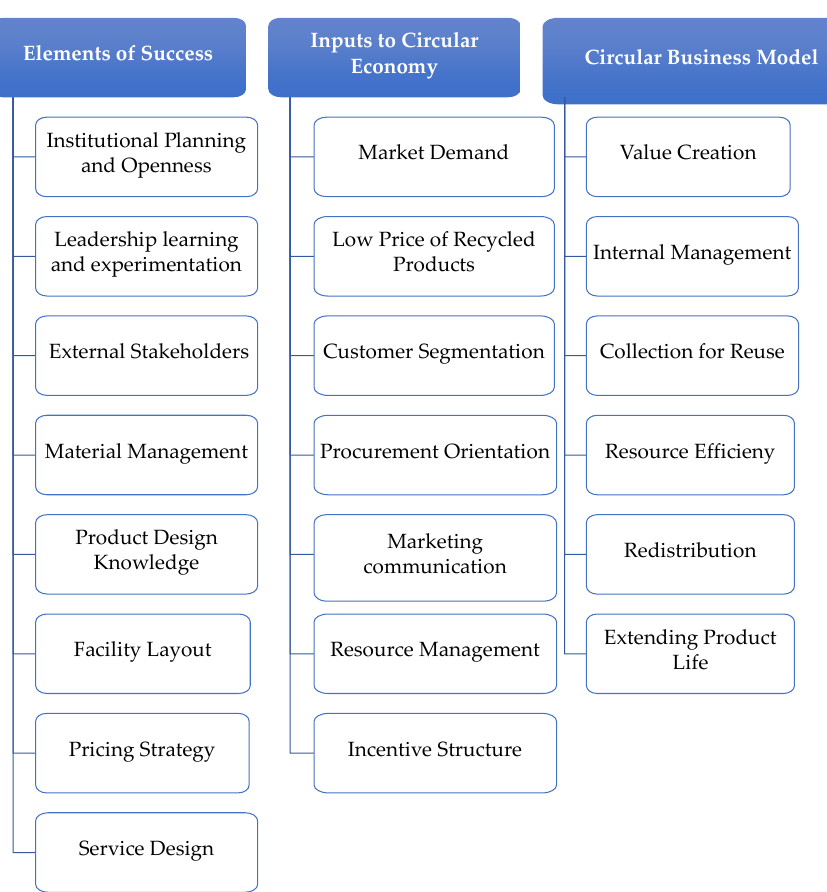
Figure 3. Business model success, inputs, and design elements within system